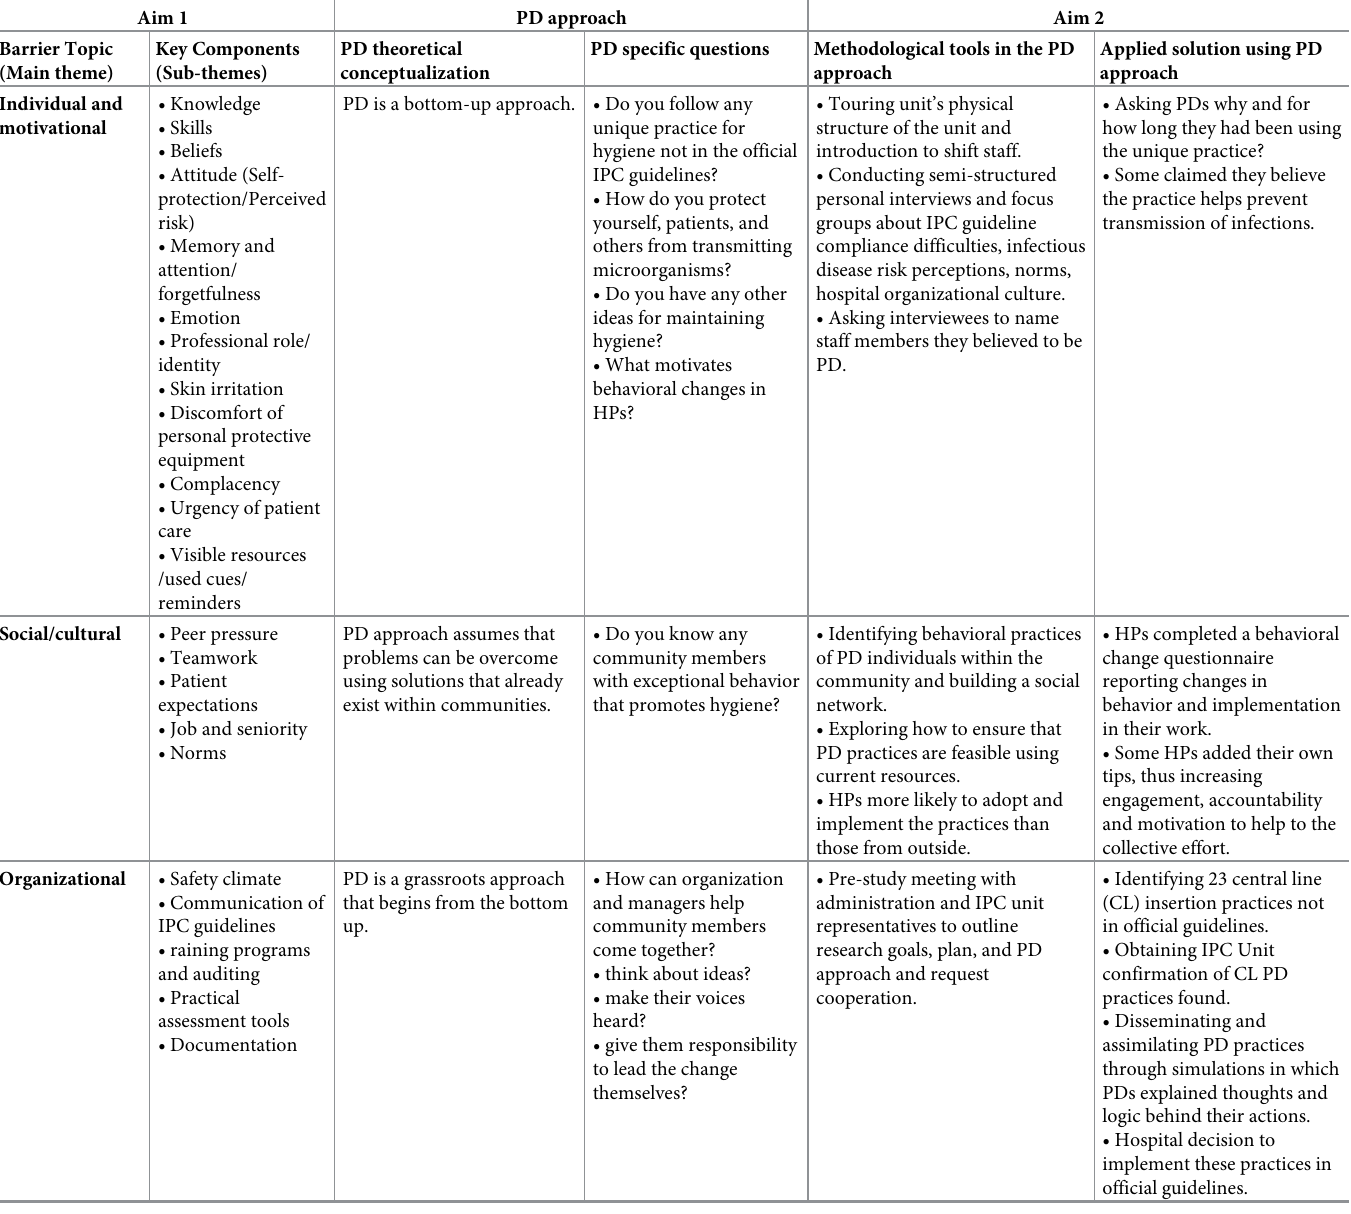
Table 2. Integrative table showing HPs’ barriers to adhere with IPC guidelines, methodological tools, and examples of applied solutions using the PD approach framework. Aim